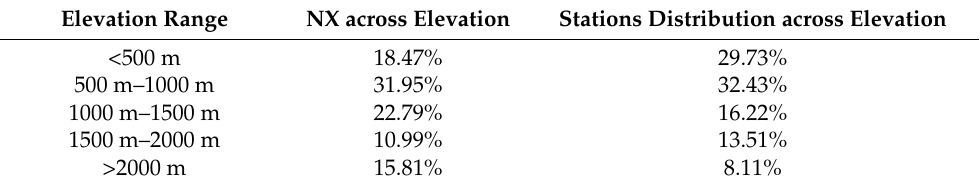
Table 5. Stations distribution and NX across elevation.